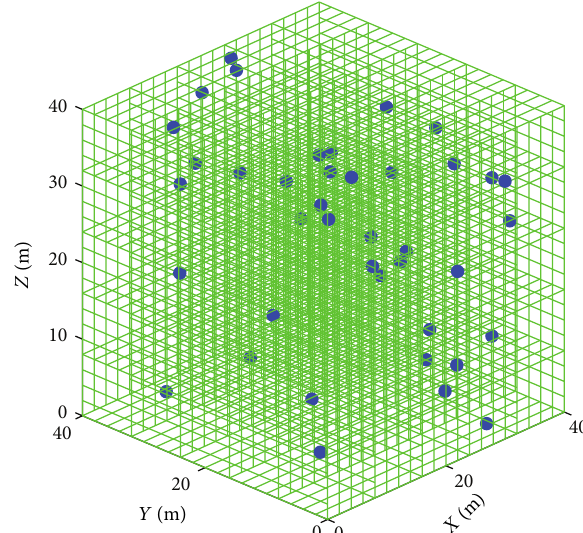
Figure 16: The geometry of a space station.